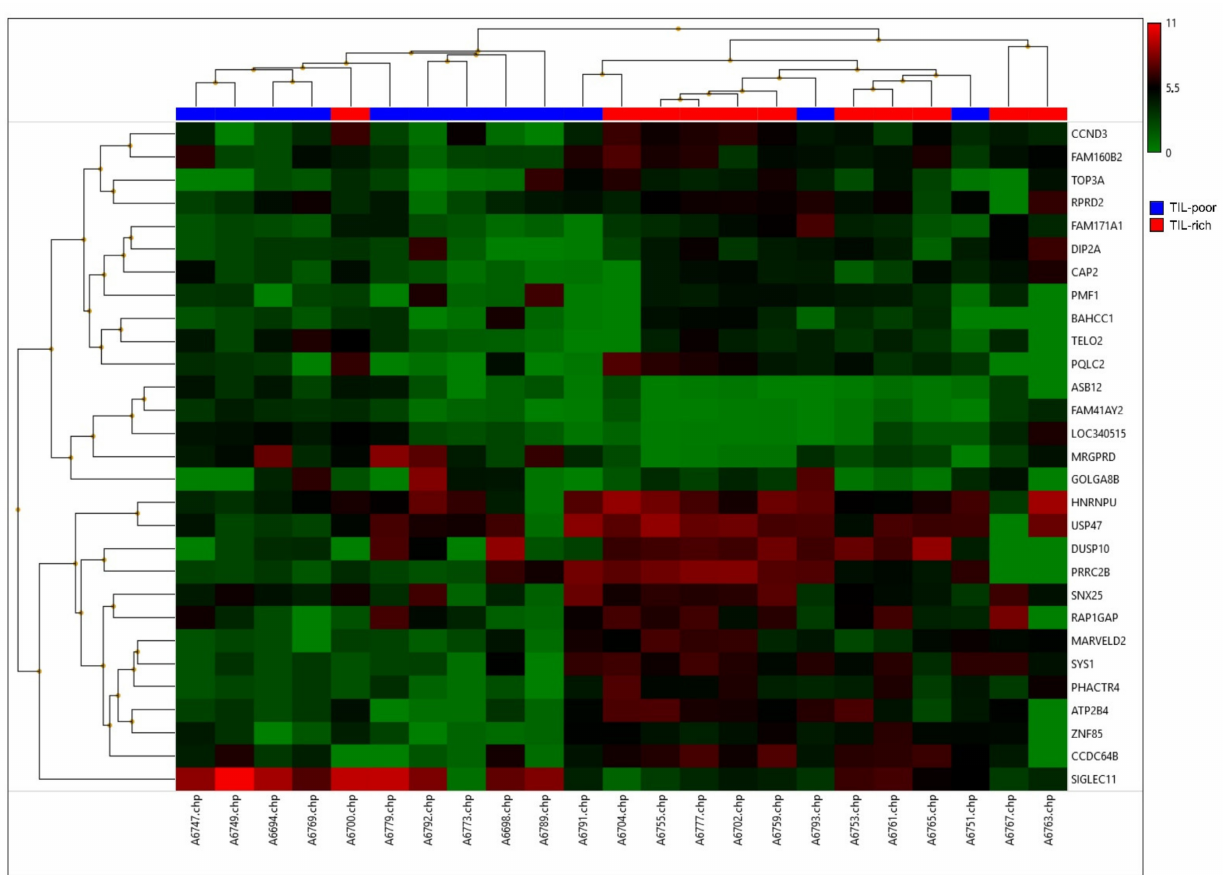
Figure 2. A hierarchical cluster of the top 29 differentially expressed genes. High expression is depicted in red and low expression is depicted in green. TIL-poor DCIS is depicted in blue and TIL-rich DCIS is depicted in